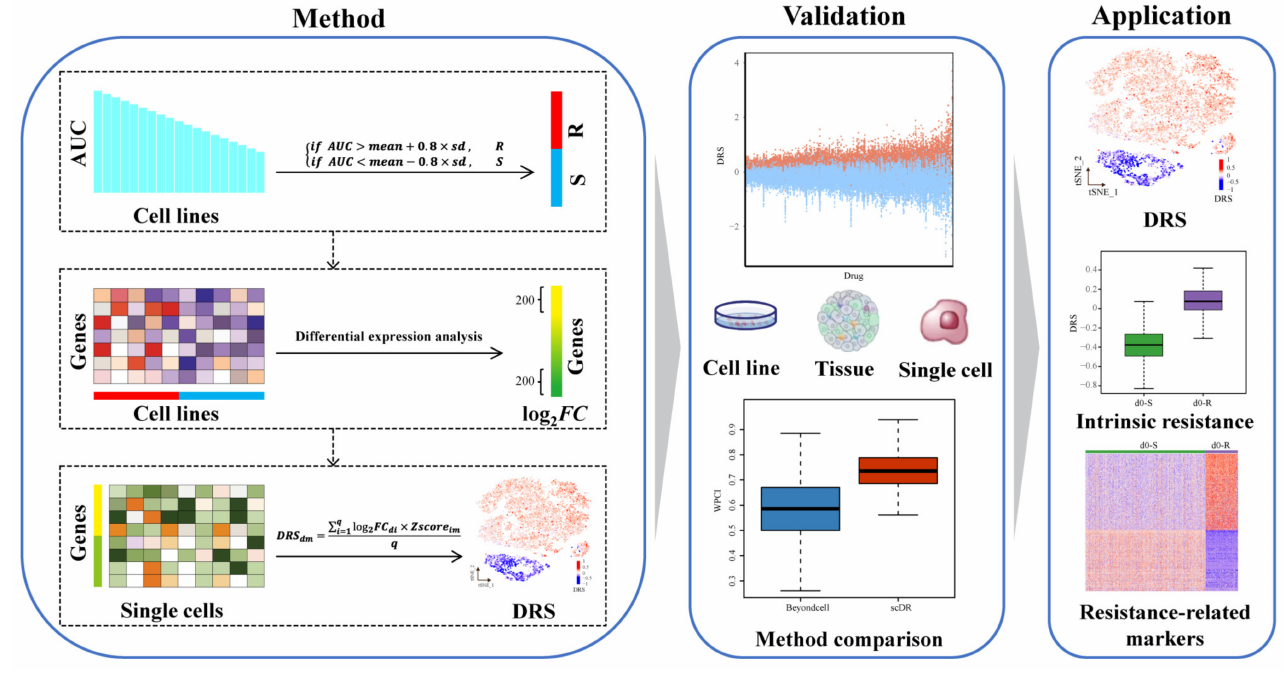
Figure 1. Workflow of